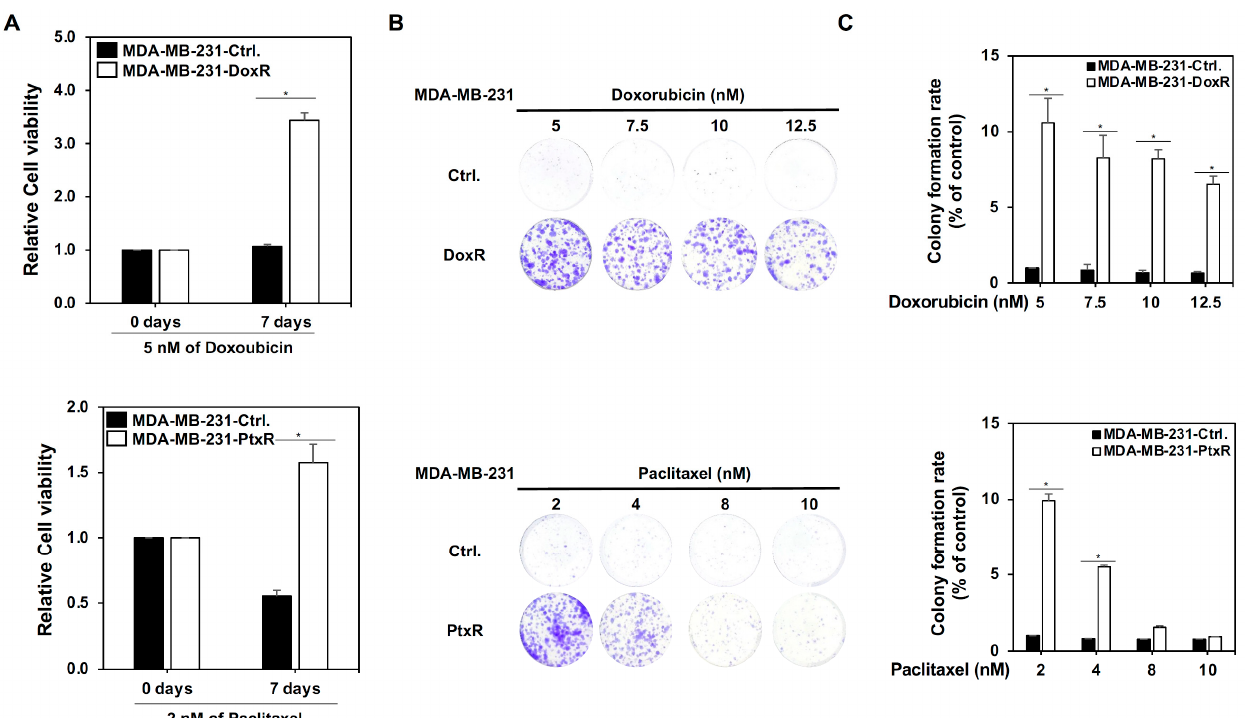
Figure 2. Generation of chemo-drug resistant TNBC. ( A ) Analysis of the viability of doxorubicin- resistant MDA-MB-231 (upper) and paclitaxel-resistant MDA-MB-231 (lower) cells treated with 5 nM of doxorubicin or 2 nM of paclitaxel for 7 days compared with parental MDA-MB-231 cells, assessed using MTT assays. ( B ) Analysis of growth of doxorubicin-resistant MDA-MB-231 (upper) and paclitaxel-resistant MDA-MB-231 (lower) cells compared with parental MDA-MB-231 cells treated with a serial dose of doxorubicin and paclitaxel, assessed performing colony formation assays. ( C ) Quantitative analysis for colony formation assays in MDA-MB-231-DoxR and MDA-MB-231-PtxR cells treated with doxorubicin or paclitaxel, respectively. Data are represented as the mean ± SEM for biological triplicate experiments. * p < 0.05, compared with the results for control cells.